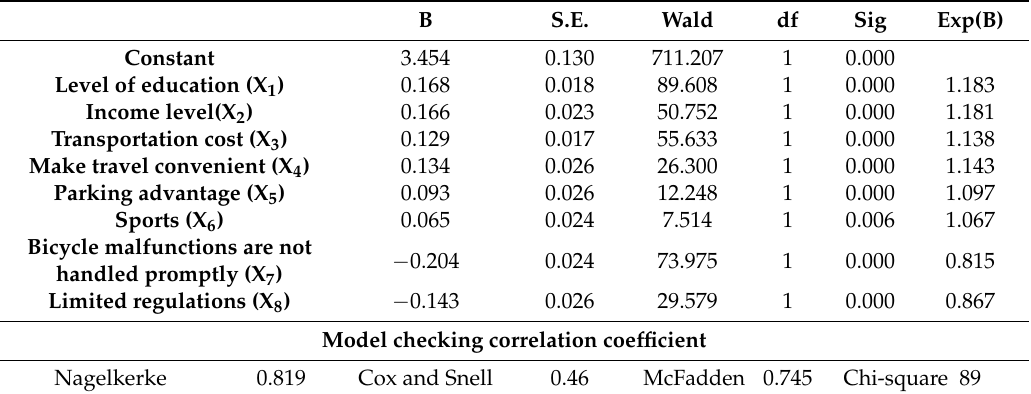
Table 3. Estimation results of the